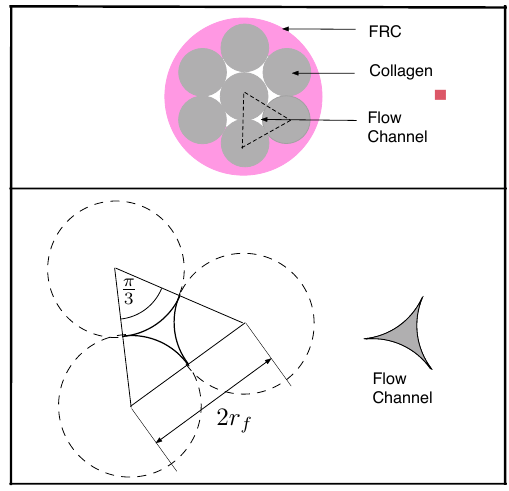
Figure 7. Diagram showing the packaged bed model of an FRC conduit. Reticular fibres are hexagonally close packed and encased in FRCs. r f is the radius of the